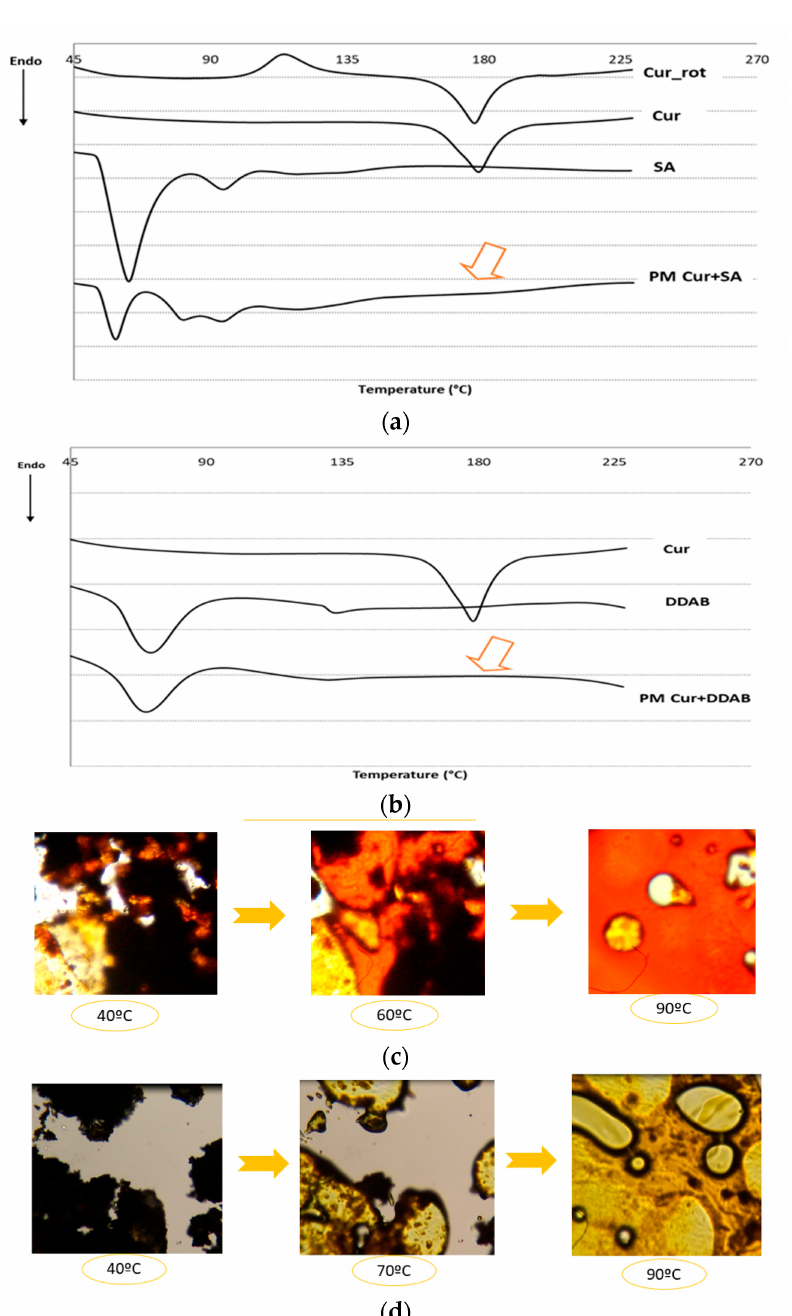
Figure 2. ( a ) Differential scanning calorimetry (DSC) profiles of physical mixtures of Cur with SA (PM Cur+SA) and raw materials. ( b ) DSC profiles of physical mixtures of Cur with DDAB (PM Cur+DDAB) and raw materials. ( c ) and ( d ) Hot stage microscope (HSM) images of PM Cur+SA and PM Cur+DDAB, respectively (Magnification: 400 ×